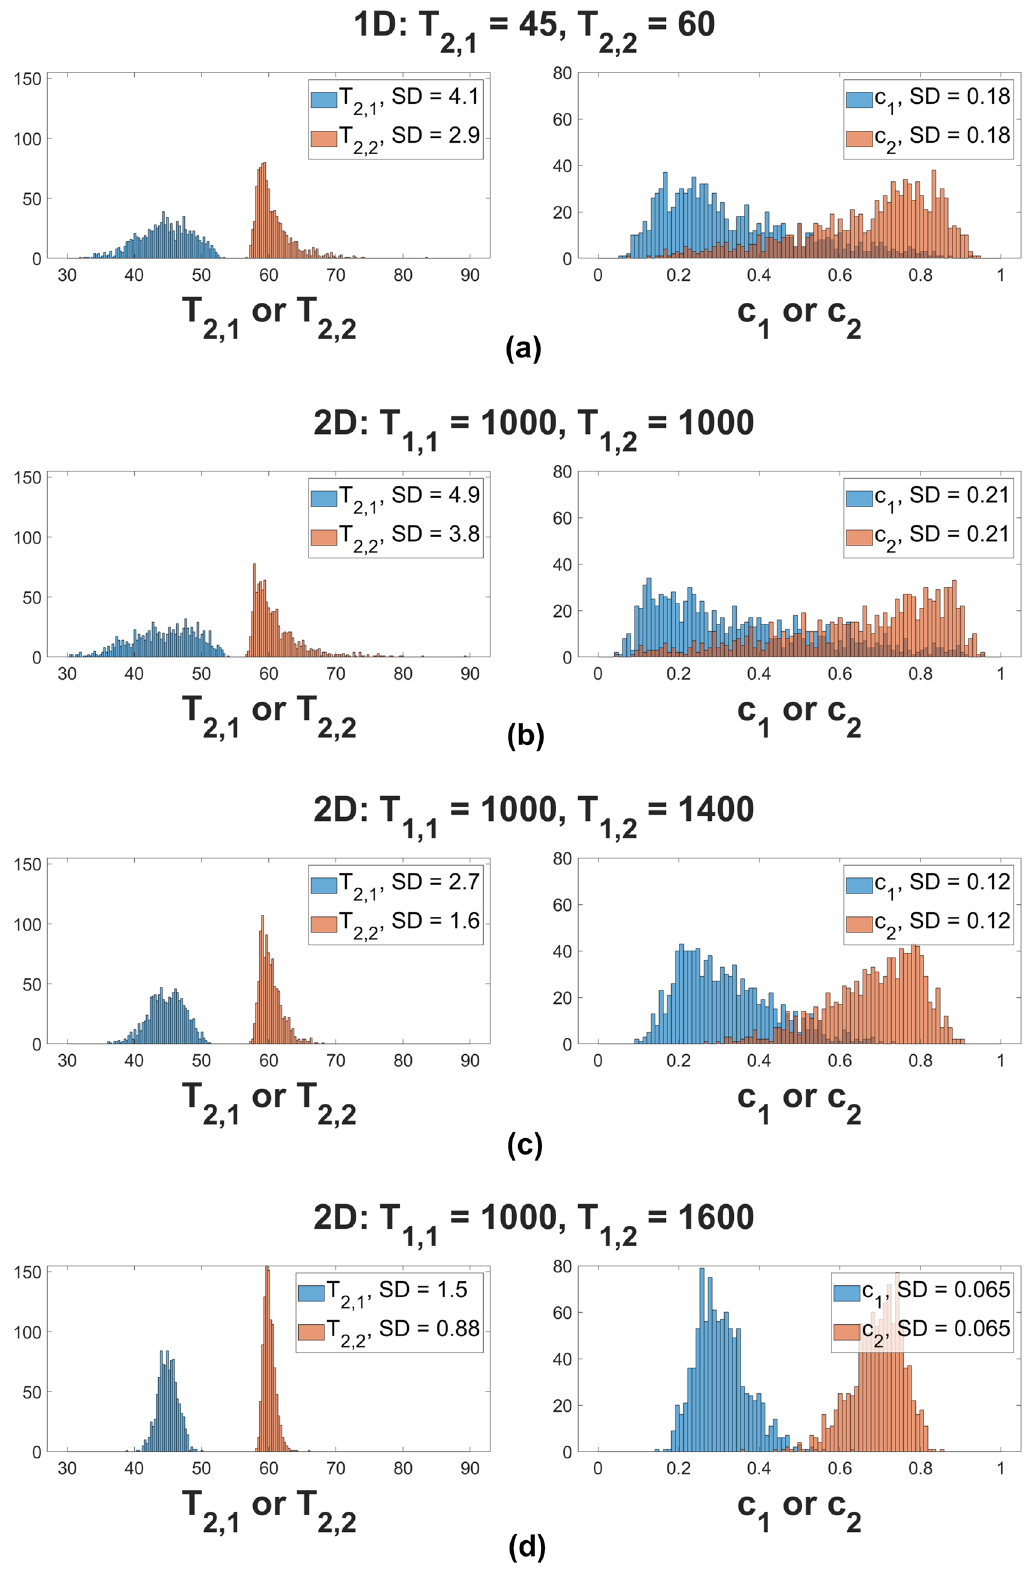
Figure 7. Histograms of 1D and 2D MC simulations over 1000 noise realizations. Row 7a shows 1D results with underlying parameters as indicated. Panels 7b, 7c, and 7d show 2D results; all plots share the same underlying values with the 2D